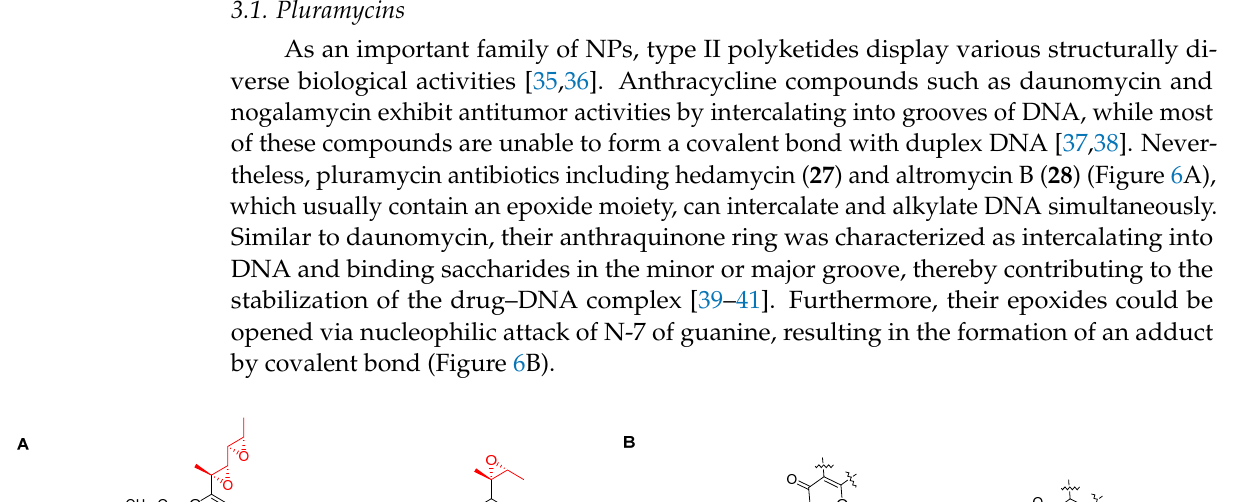
Figure 7. Proposed biosynthetic pathway of hedamycin. KS, ketosynthase; KR, ketoreductase; ACP, acyl carrier protein; DH, dehydratase; AT, acyl